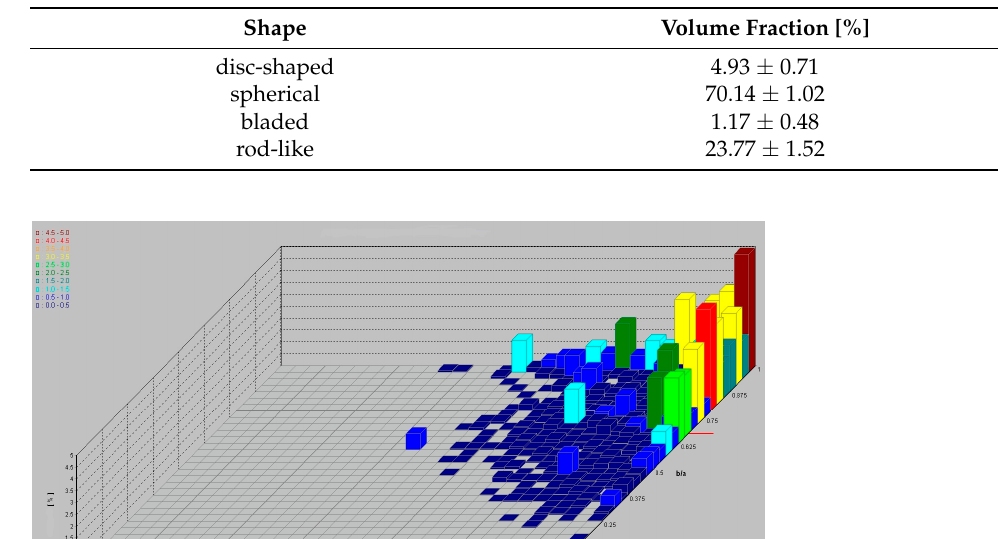
Table 1. Zingg’s shavings shape classification.